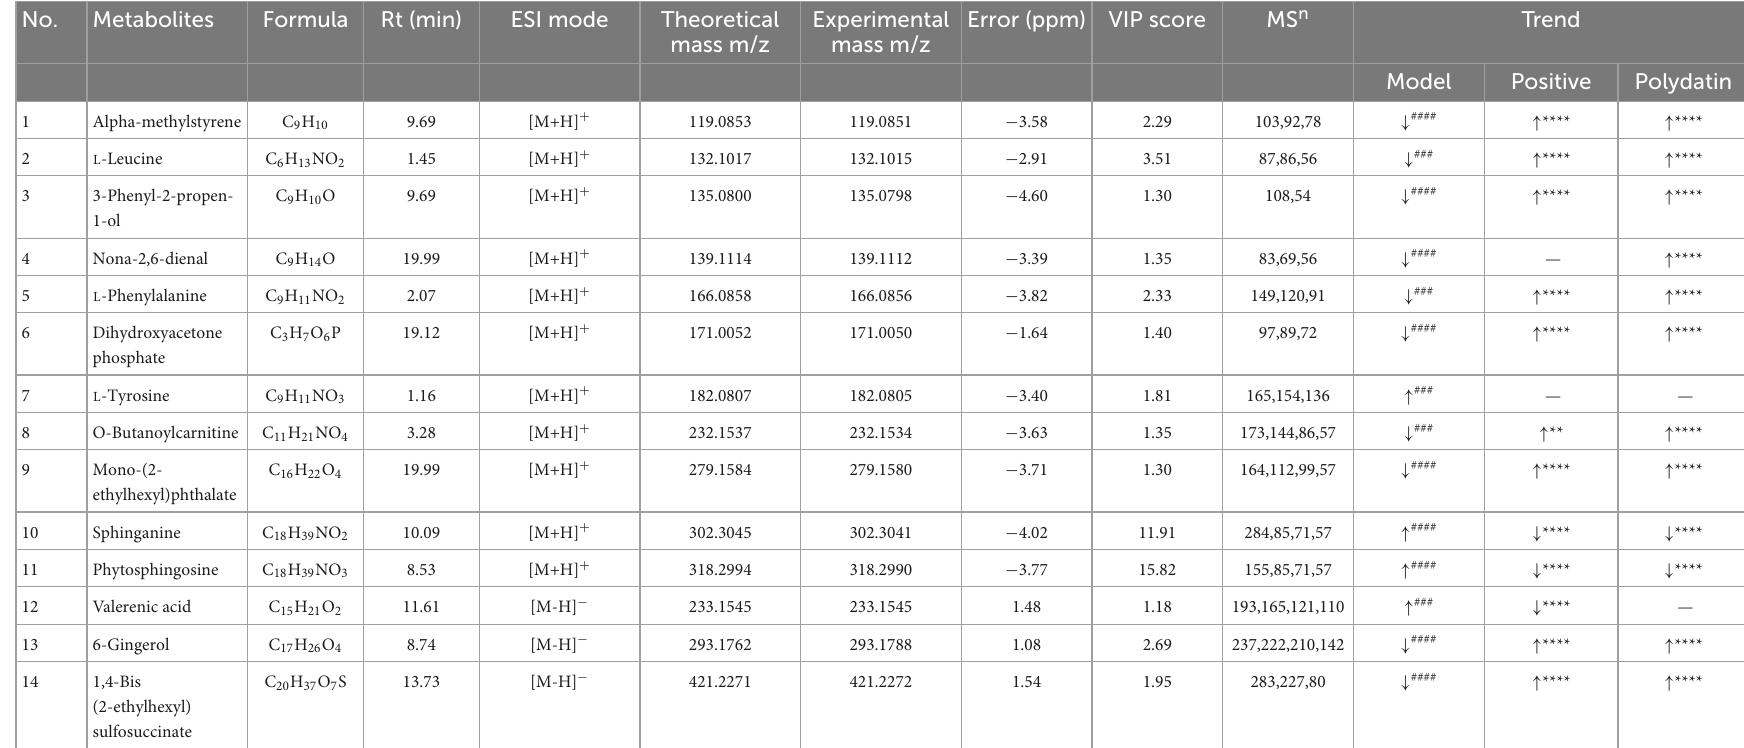
TABLE 1 Identification of different metabolites and the change trends of metabolites in different groups.